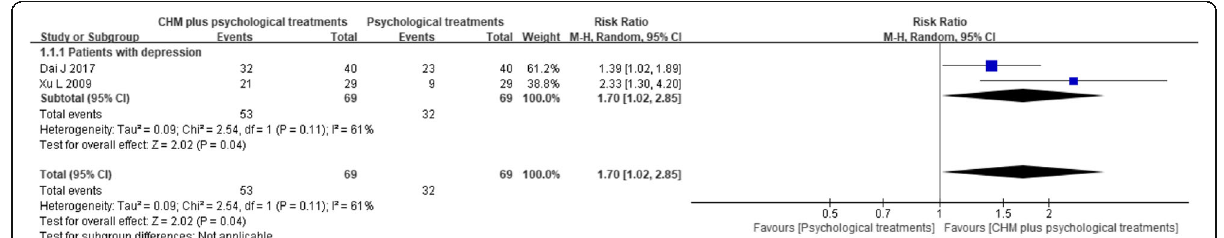
Fig. 10 Forest plot of the depression treatment response rate for CHM plus psychological treatments versus psychological treatments